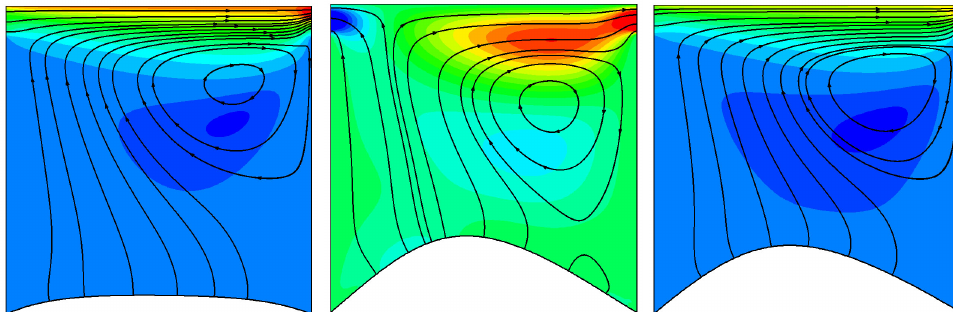
Figure 4. Vertical displacement at mid-point of flexible plate in lid-driven open cavity flow with flexible bottom wall, velocity and streamlines at t = 2.5, 15, 20 s.